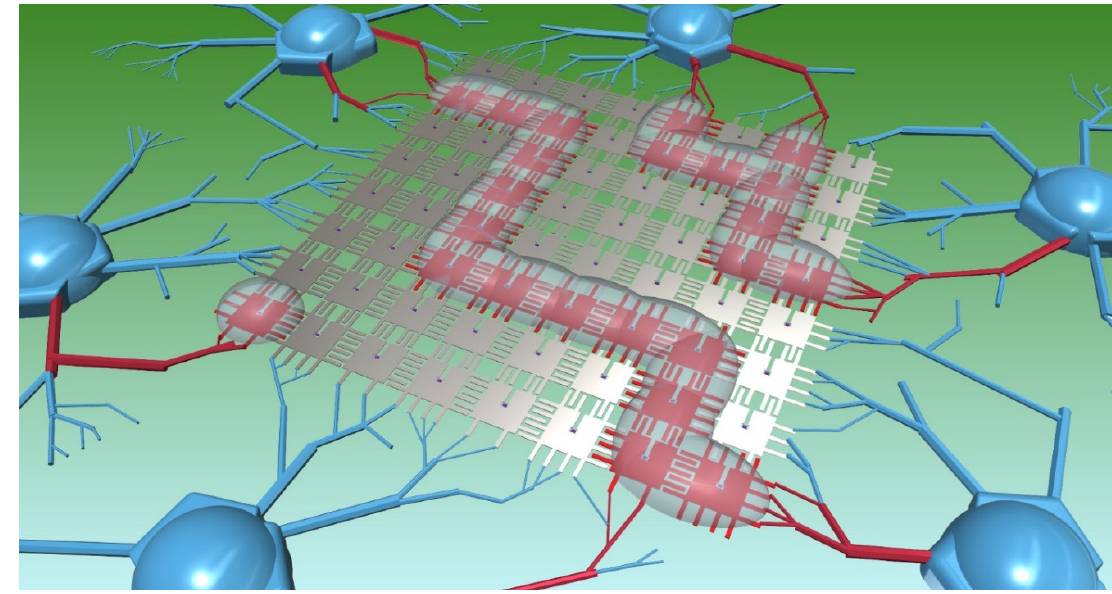
Figure 5. Conceptual model of a 2D array programmable electrofluidic neuromorphic device capable of multi-pixel biasing. Here, three ionic liquid droplets are shaped via electrowetting into user defined channels, allowing specific chosen pixels (highlighted in red) to be programmed.